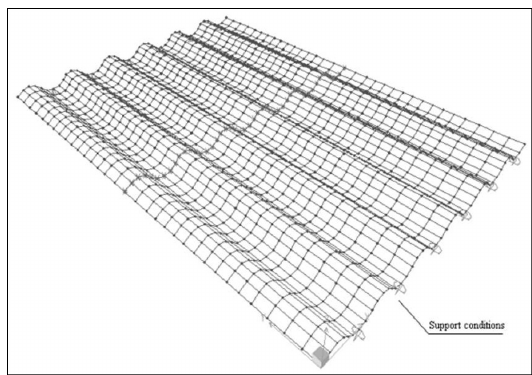
Figure 4. Support conditions admitted in the models. Table 1. Support conditions and lengths admitted for the sheets under bending. Length of the sheets